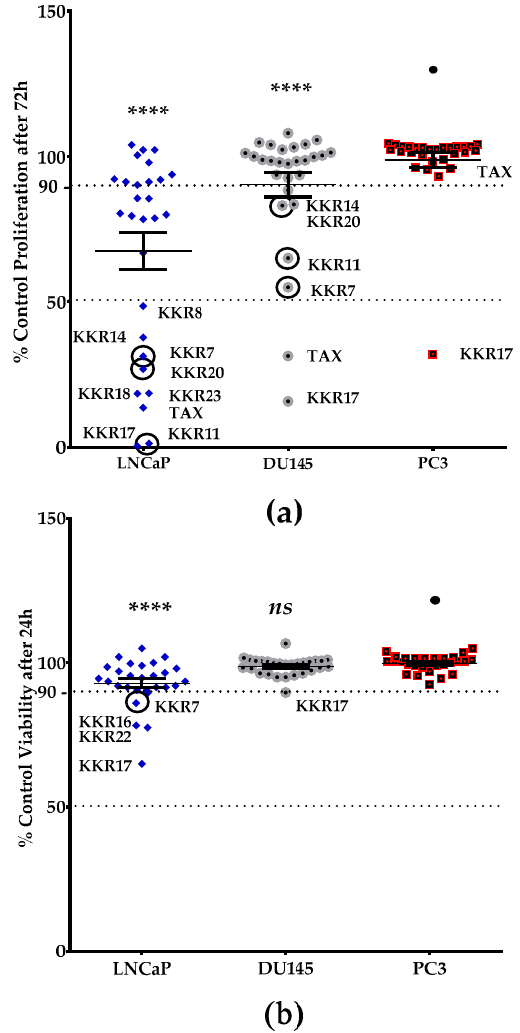
Figure 6. Screening the 20 KKR compounds for their cytotoxic and antiproliferative effects on THE three prostate cancer cell lines (PCa). Each 50 μ M KKR-treated group of LNCaP, DU145, and PC3 cells was compared to the control of THE untreated cells. Cell viability was measured after 24 h ( a ), while cell growth was measured after 72 h ( b ) of incubation. TAX of 0.25 μ M was used as a standard antiproliferative drug. Circled data points represent the repeatedly potent KKR compounds with anticancer effect, in addition to their MAO-A inhibitory activity. For all cell lines examined, every single data point represents the mean of percentage control total resazurin reduction by the viable cells ( n ≥ 2, SEM ≤ 20%). The significance of the difference between the least affected PC3 group (•) and other cells was determined using two-way ANOVA, followed by Dunnett’s multiple comparisons test; ns — non-significant, **** p < 0.0001.